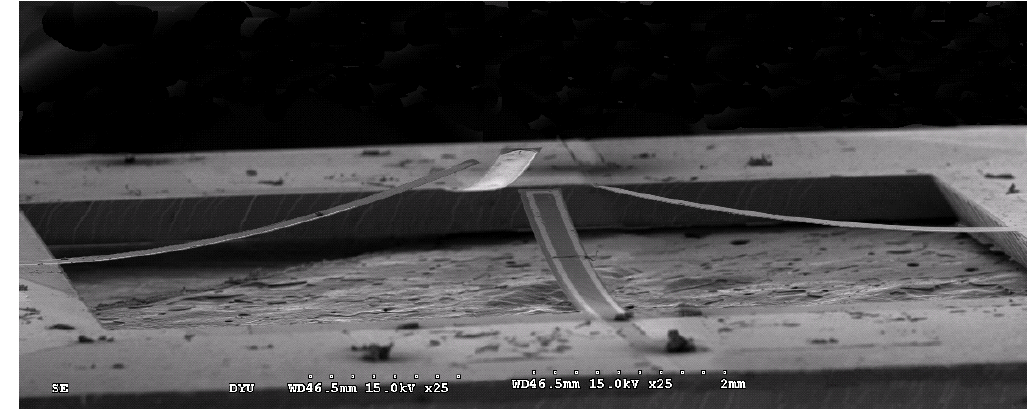
Figure 5. SEM image of flow direction sensor comprising four microcantilevers in a cross- form configuration.